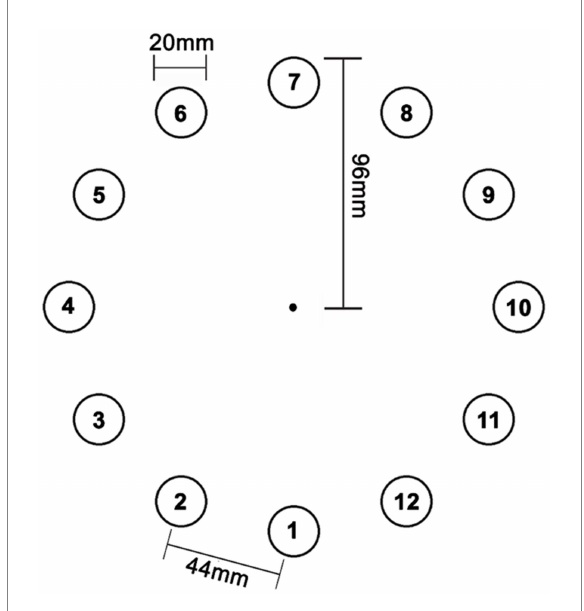
FIGURE 2 Schematic of the spatial locations of the 12 targets. Each target was 20 mm in diameter with a tangential distance of 44 mm between any adjacent targets. The radius of the circular array was 96 mm. The repeated sequence consisted of targets 11, 10, 5, 9, 7, 3, 6, and